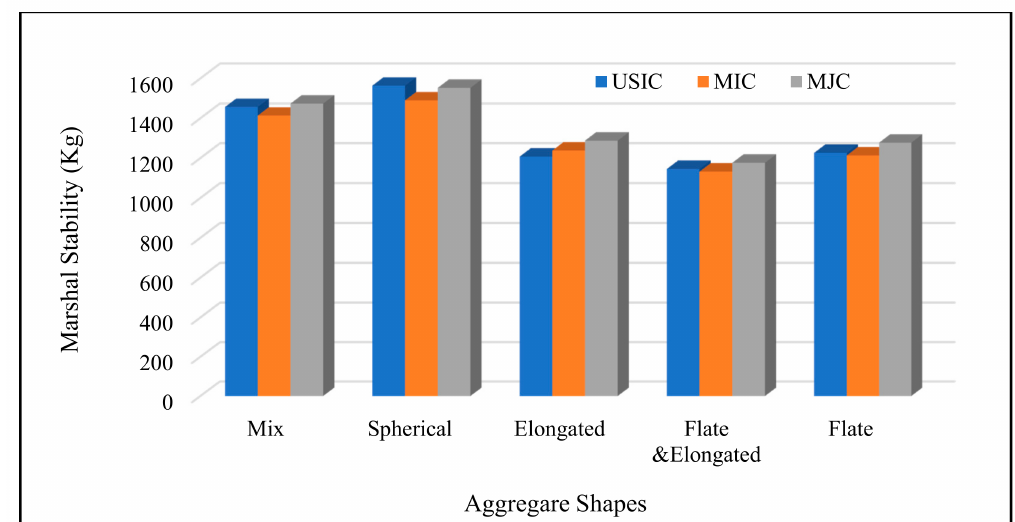
Figure 12. Effect of Marshall stability on aggregate shape and crusher type.